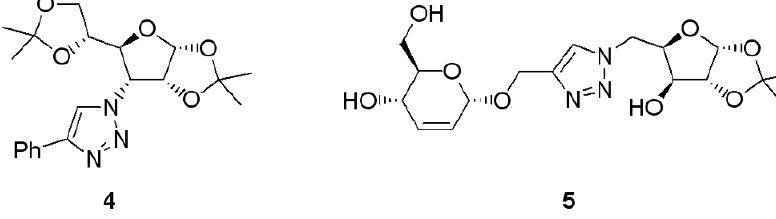
Figure 2. Acetonide-protected carbohydrates as mediocre inhibitors of α